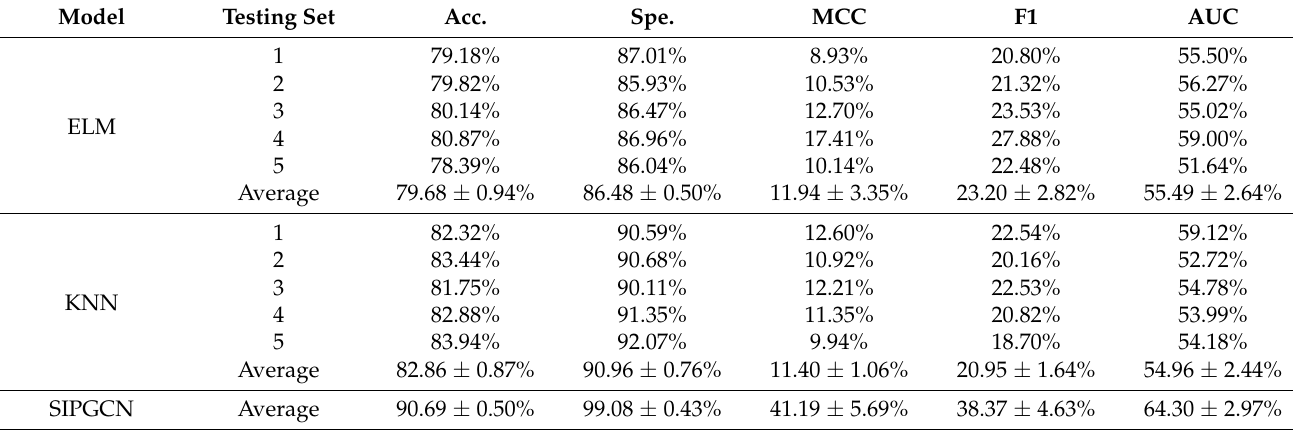
Table 4. The outcomes of different classifier models in the yeast data